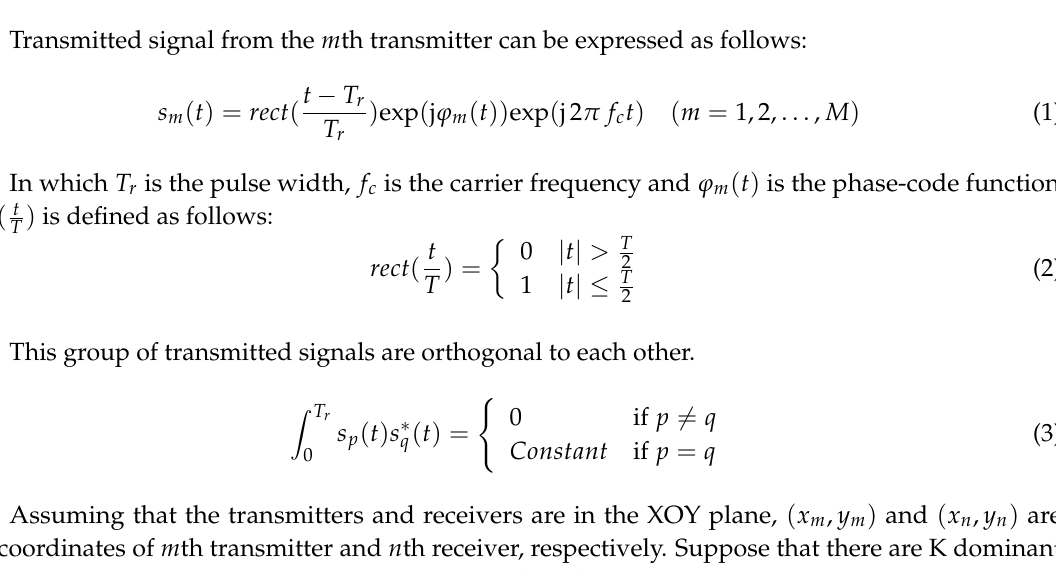
Figure 1. The imaging geometry of the proposed